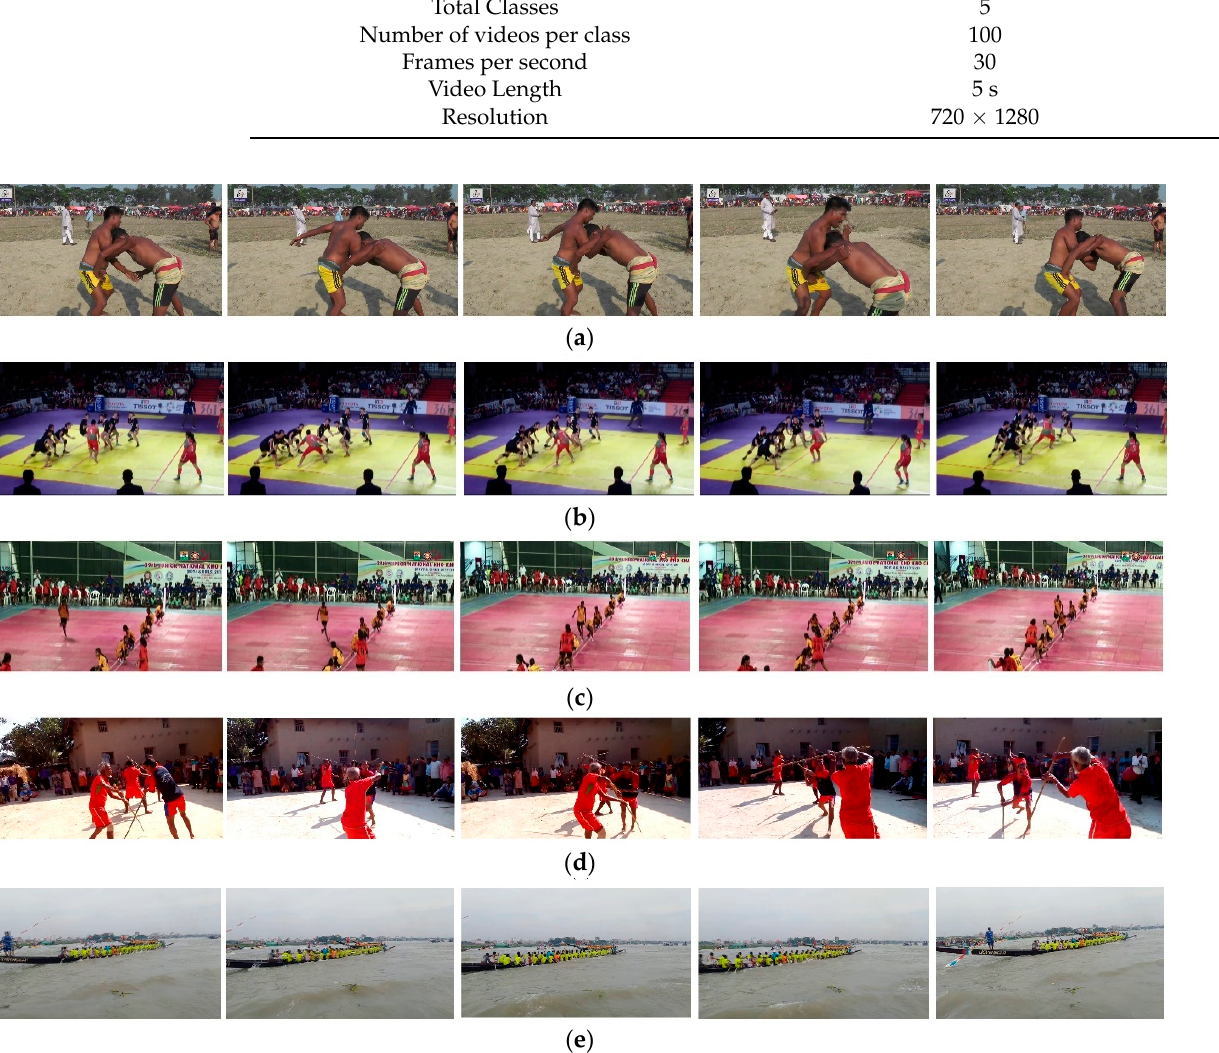
Figure 3. Sequential frames of ( a ) Boli Khela; ( b ) Kabaddi; ( c ) Kho Kho; ( d ) Lathi Khela; ( e ) Nouka Baich.